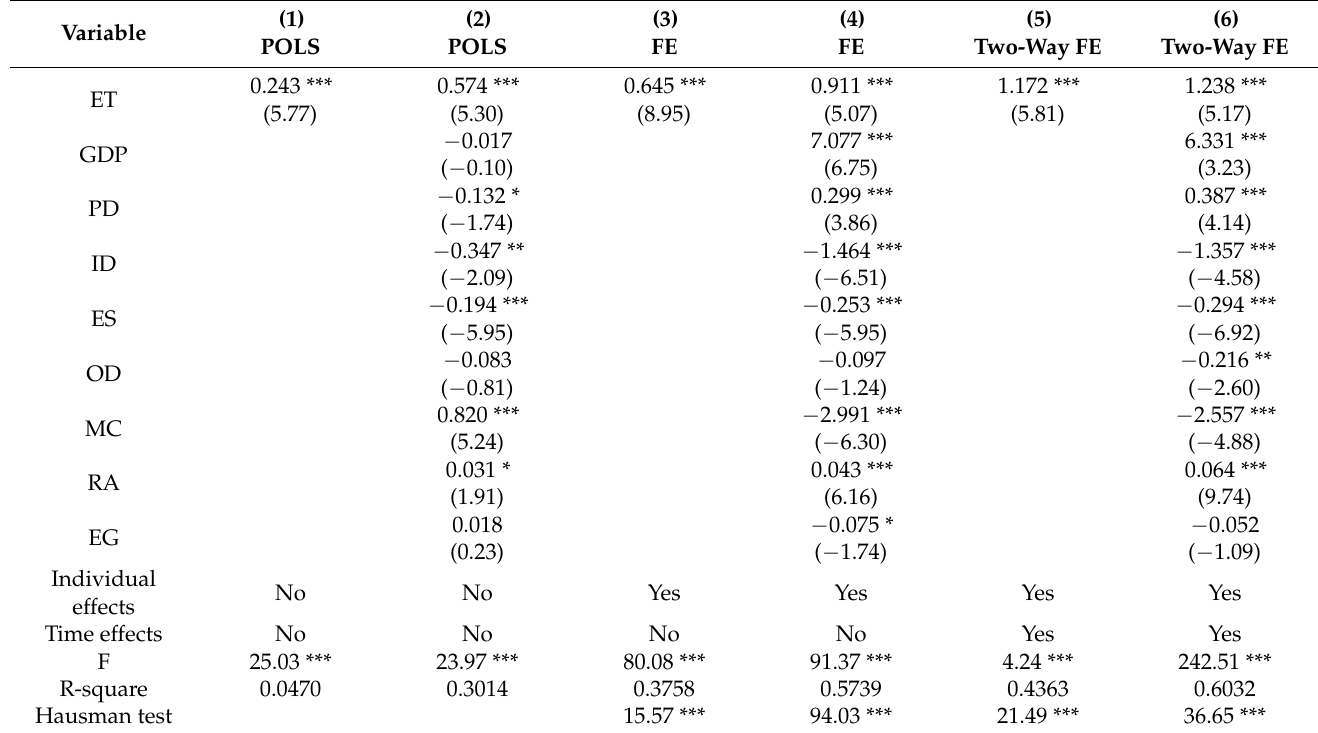
Table 2. Results of benchmark